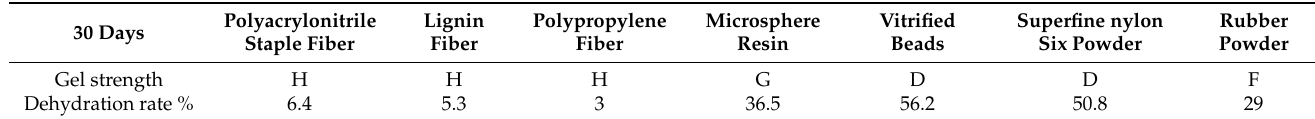
Table 4. Effects of Stabilizers on the Gel Dehydration Rate.